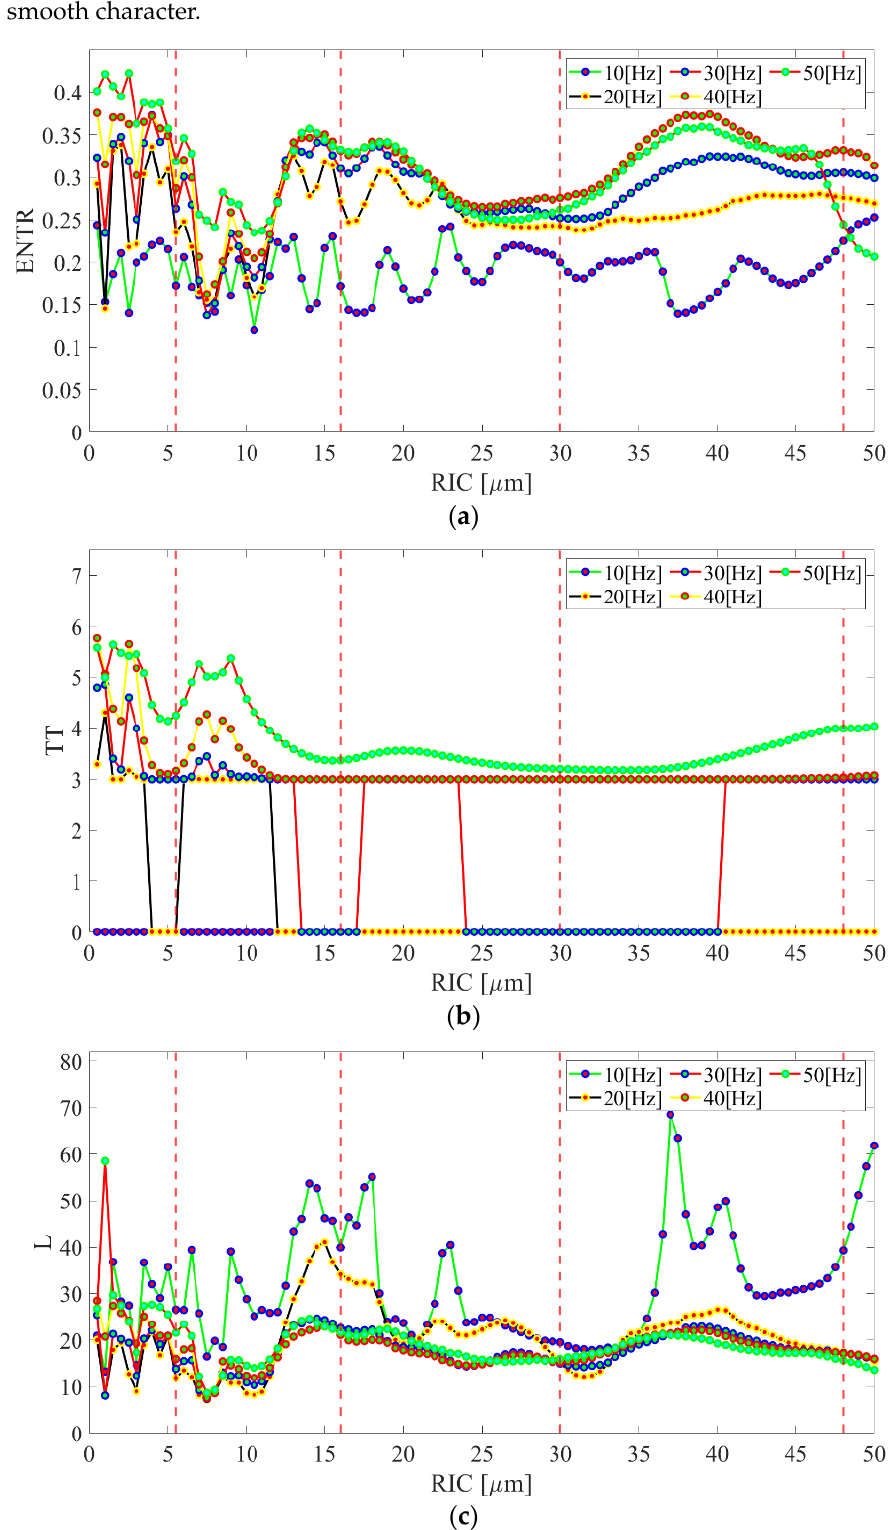
Figure 10. Results of the recurrence quantificators for the results obtained from mathematical model: ( a ) Entropy —ENTR , ( b ) Trapping Time— TT , ( c ) Average length of the diagonal line— L .